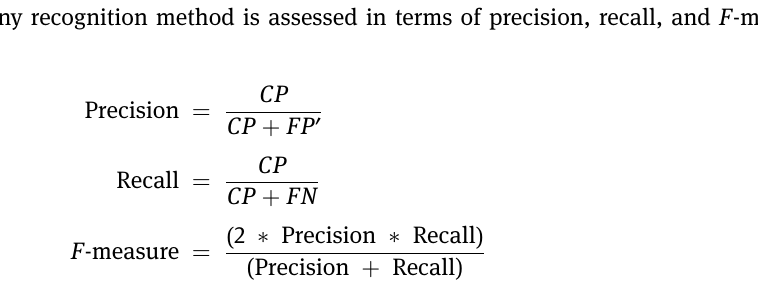
Figure 6: Confusion Matrices for Each Feature Type ( FT 1 , FT 2 and FT 3 ) for Both Divisions, respectively. and the average F -measure is computed from all trials. Table 1 gives the class wise performance in terms of F -measure (for both the ratios belonging to all the feature types) and also presents validated meta-values for the RBF-kernel. Figure 6 shows confusion matrices obtained for optimised parameters of the classifier (for each feature type: FT 1 , FT and FT 2 3